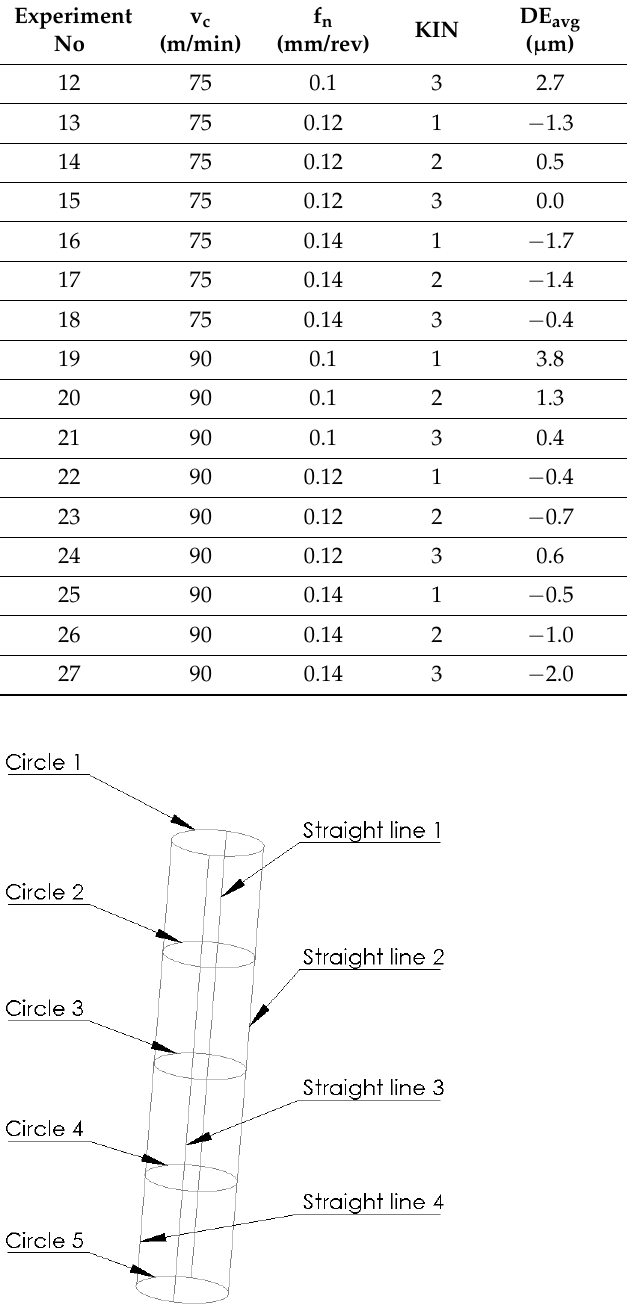
Figure 4. Measurement strategy. The experiment required deriving Taguchi L27 orthogonal arrays for three input parameters each at three levels (3 × 3 × 3). Table 4 shows all the sets of the input parameters with their